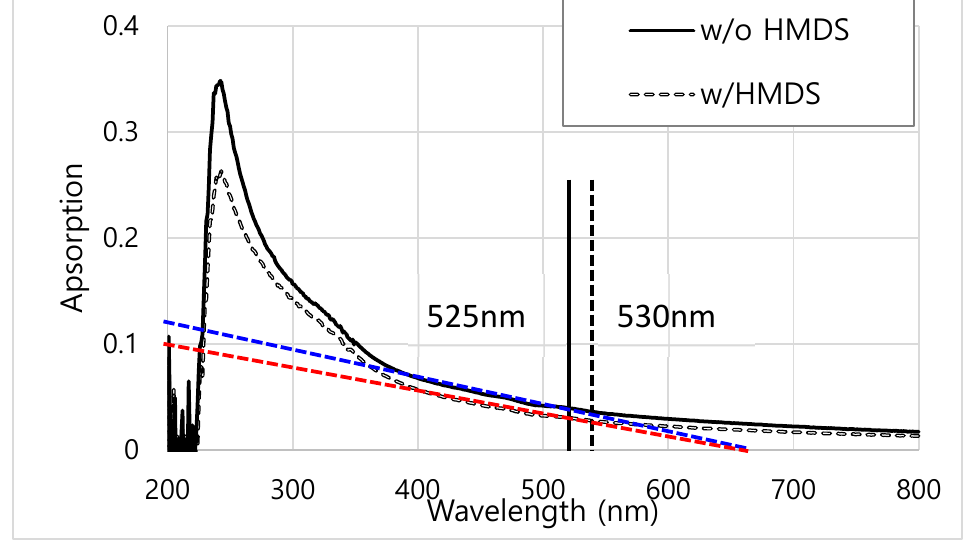
Figure A2. Bandgap measurement of QDs using UV-visible spectrometry. Table A1. Wavelength and bandgap energy of QDs without and with HMDS.